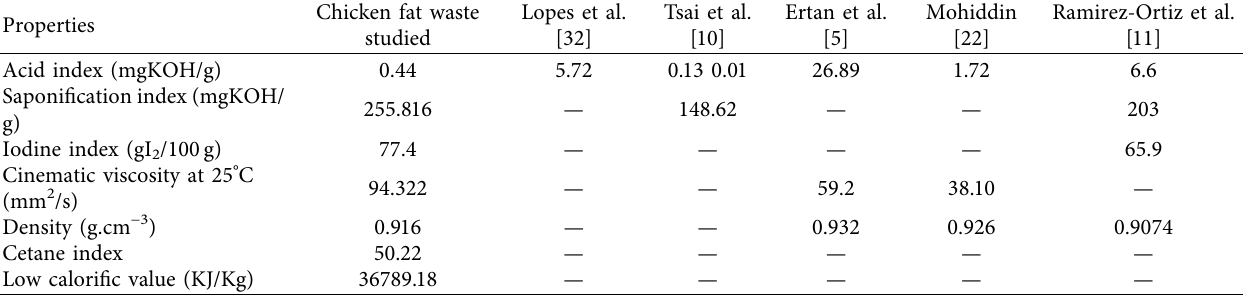
Table 3: Physical-chemical property of chicken fat waste compared to those obtained in the literature.